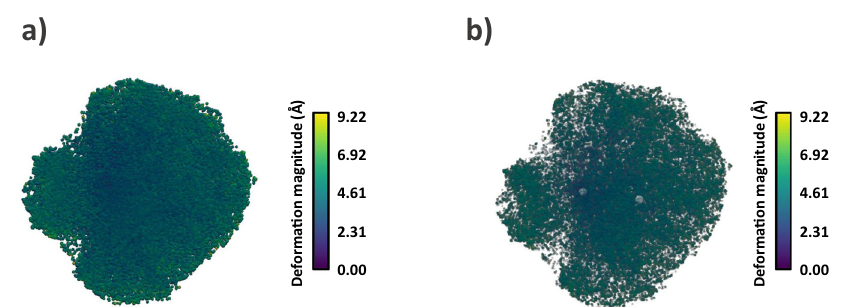
Fig. 6 | SARS-CoV-2 Zernike3D conformational landscapes. a UMAP repre- sentation of the Zernike3D coef fi cient space for the SARS-CoV-2 coronavirus spike open state obtained from the particles analyzed previously in ref. 17 . Each point in the space represents a different particle conformation. b Combined analysis of particles and volumes (in white dots) corresponding to the two RBD states